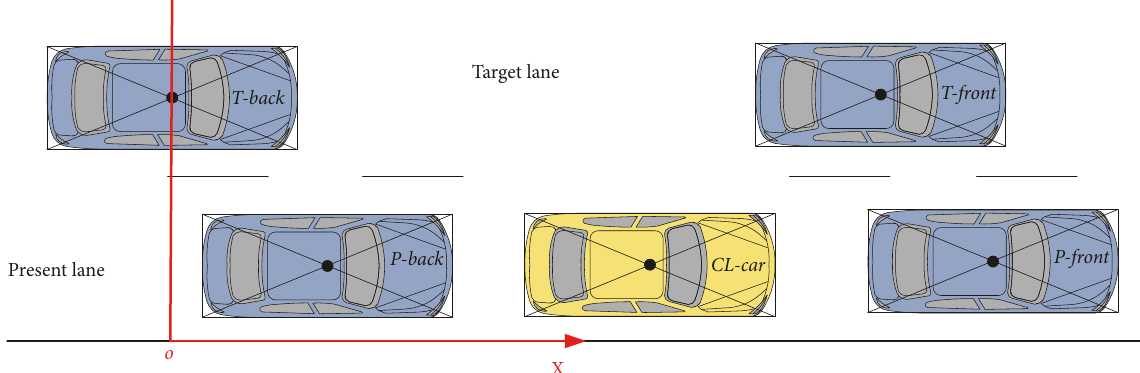
Figure 3: Definition of coordinate axes and coordinate origins.